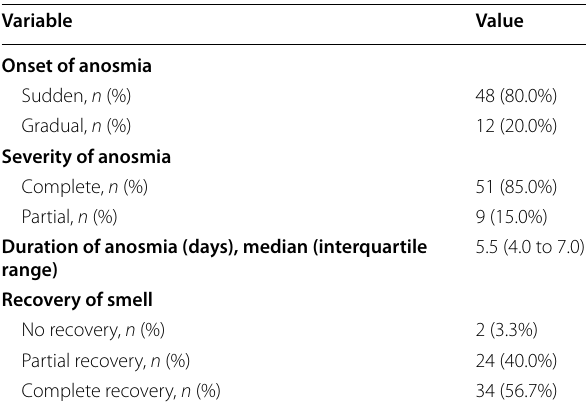
Table 2 Characteristics of